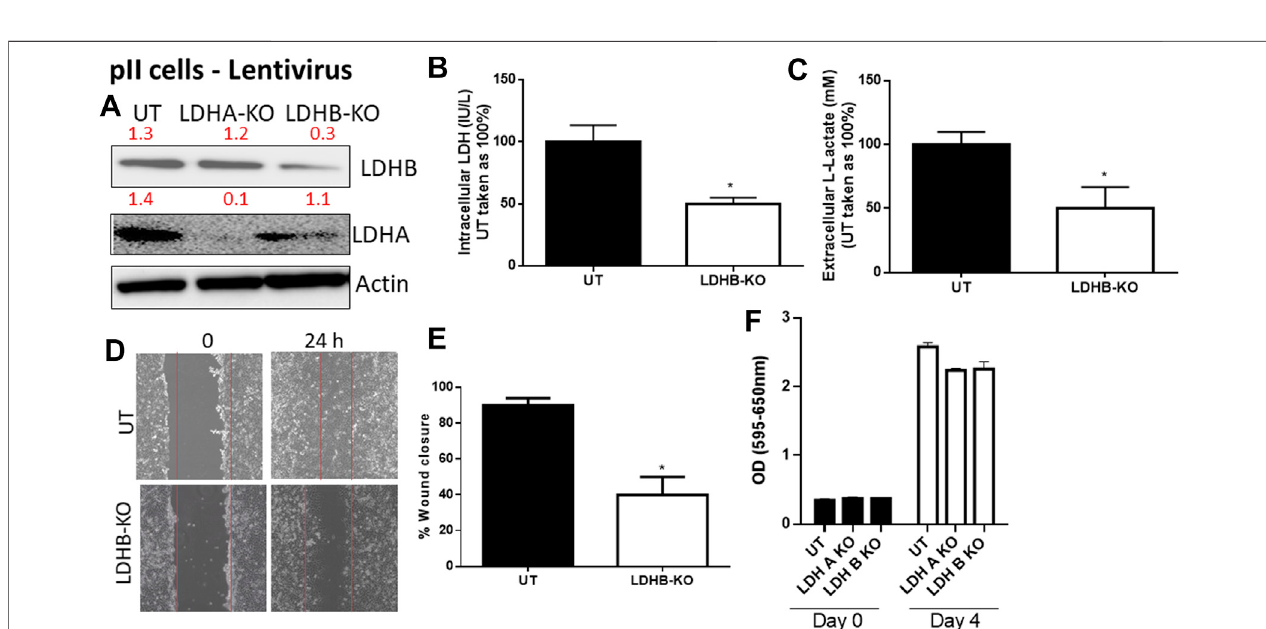
FIGURE 4 | Effect of LDH-B knockdown in the ER − ve breast cancer cell pII. (A) show western blotting analysis of LDH-B and actin (loading control) in untreated (UT), or cells treated with LDH-A or -B lentivirus. Densitometric analysis of the blot is also included. The blot represents one out of three similar experiments. (B,C) show LDH activity and lactate level respectively. * p < 0.05 Vs. UT cells ( n (cid:2) 3 per group). (D,E) show the percentage of wound closure (using scratch assay). * p < 0.05 Vs. UT cells ( n (cid:2) 6 per group). (F) show cell proliferation (using MTT assay) at day 0 (seeding day) and day 4 ( n (cid:2) 3 per group).